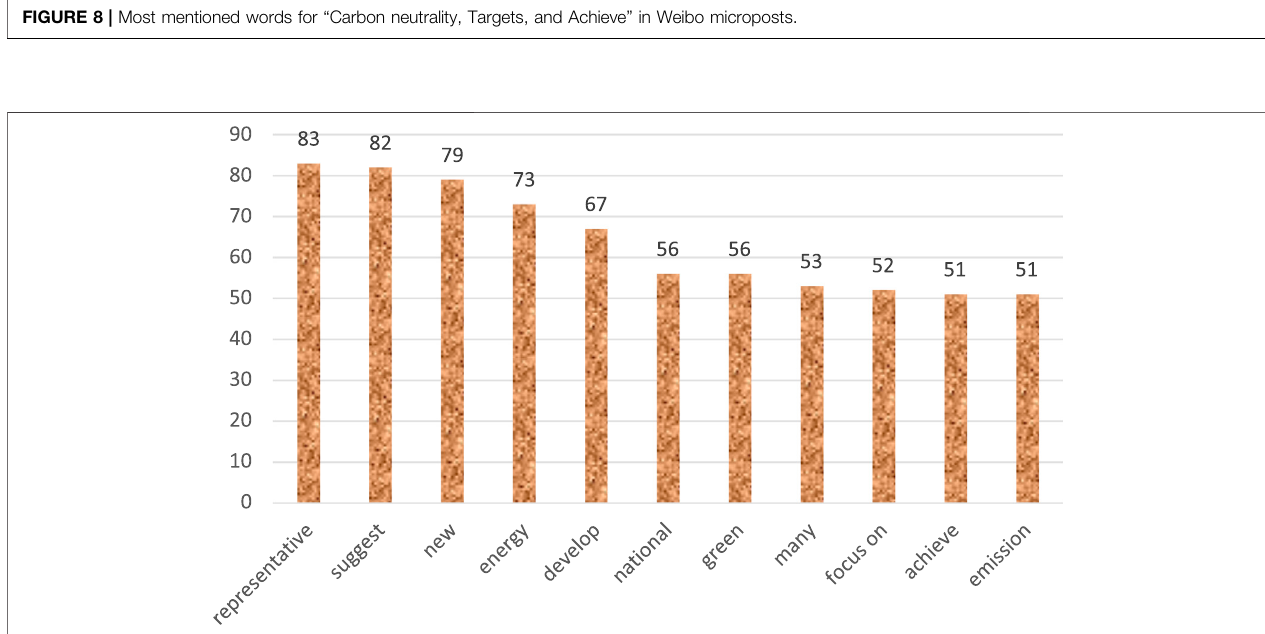
FIGURE 9 | Most mentioned words for “ carbon neutrality, two sessions and proposals ” in Weibo microposts.